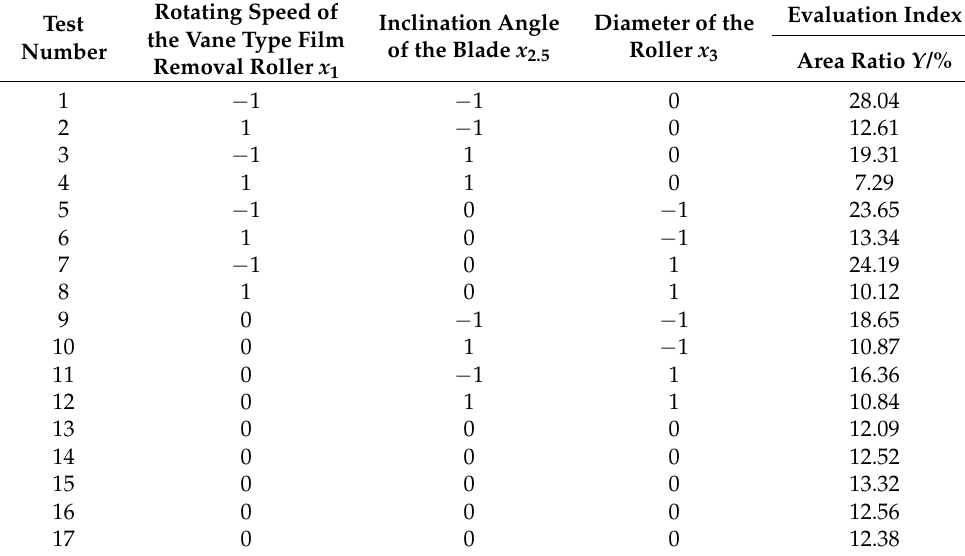
Table 4. Test plan and result.